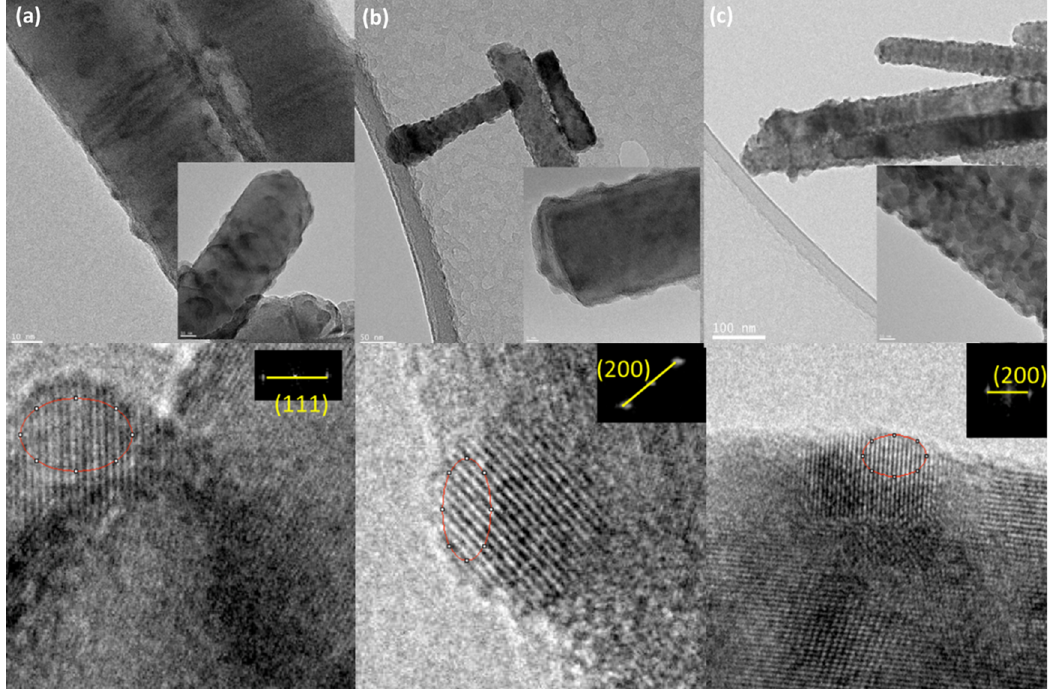
Table 3. D spacing identified by TEM and its corresponding plane. Figure 6. Low- and high-resolution TEM images demonstrate the configuration of the PbS-QD/ZnO NWs. Corresponding FFT patterns reveal the ordering of the super lattices of ( a ) PbS deposition for 16 SILAR cycles ( b ) PbS deposition for 10 SILAR cycles, and ( c ) PbS deposition for 5 SILAR